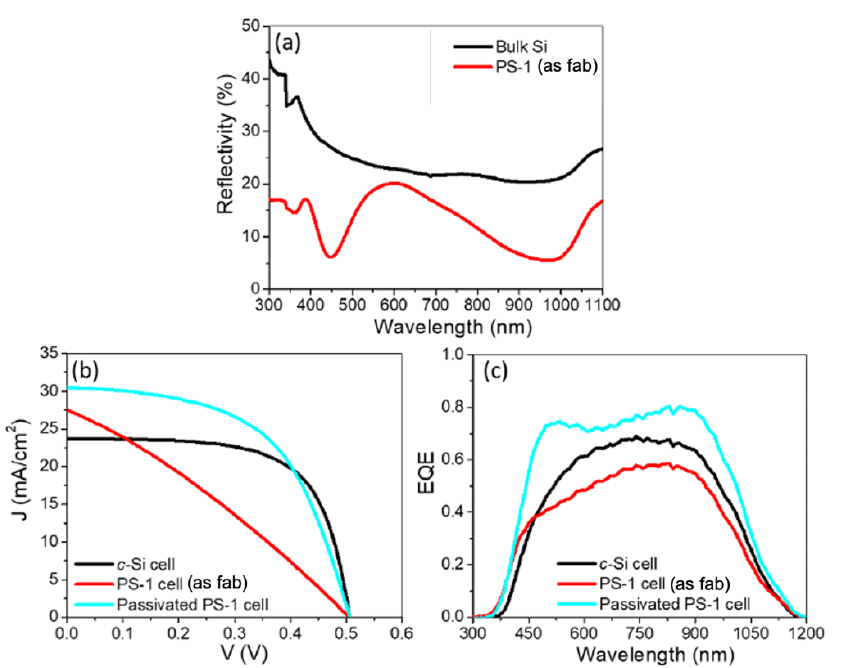
Figure 4. PV characteristics of c -Si cell, as-fabricated PS-1 cell and passivated PS-1 cell: ( a ) reflectivity spectra measured for bulk Si and PS-1 layer; ( b ) J–V curve; ( c ) EQE spectra.